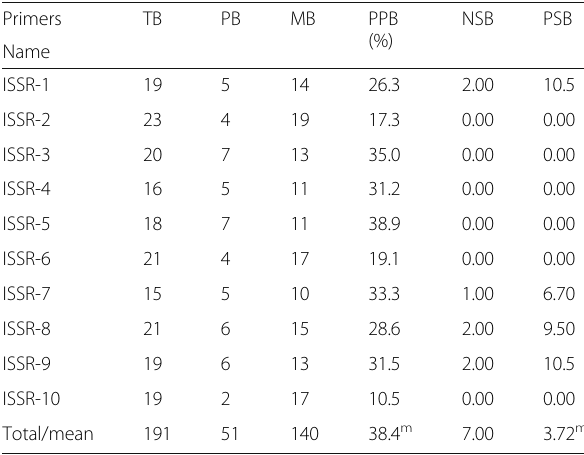
Table 2 Polymorphism level detected by the 10 ISSR primers that have been used for fingerprinting PCR analysis in Trichoderma isolates Primers TB PB MB PPB